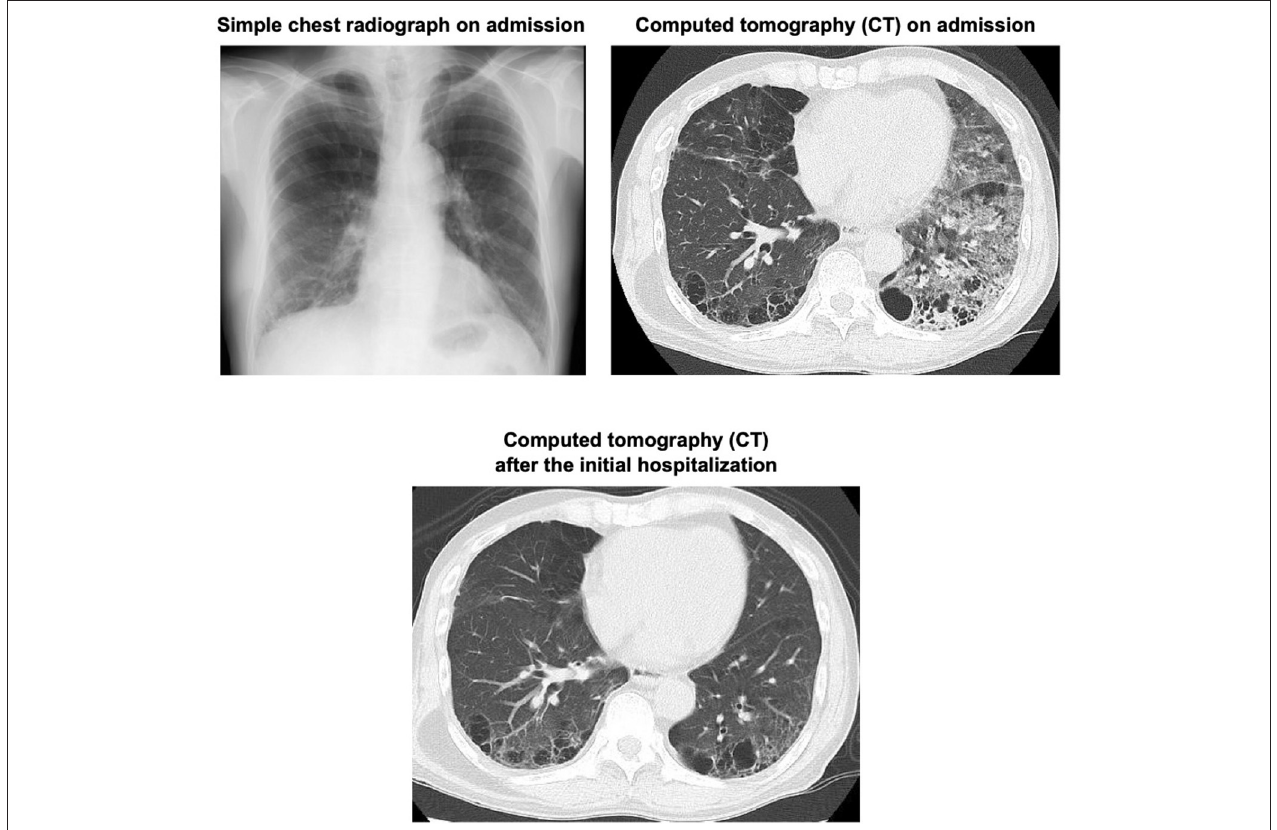
FIGURE 1 | A simple chest photograph at the time of emergency transport showed reticular shadows in the bilateral lower lung fields (upper left panel). Computed tomography (CT) at the time of emergency transport showed an infiltrative shadow with air bronchograms in the right lower lobe. There were emphysematous changes in the bilateral lungs (lower right panel). CT performed 106 days after initial discharge showed that the infiltrative shadow in the right lower lobe had disappeared (lower